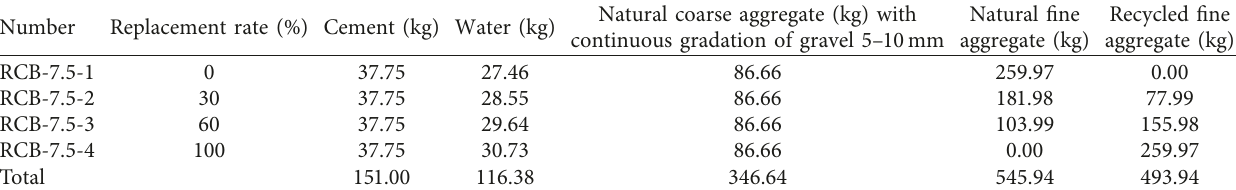
Table 2: Quantity of materials required for the MU7.5 block experiment.